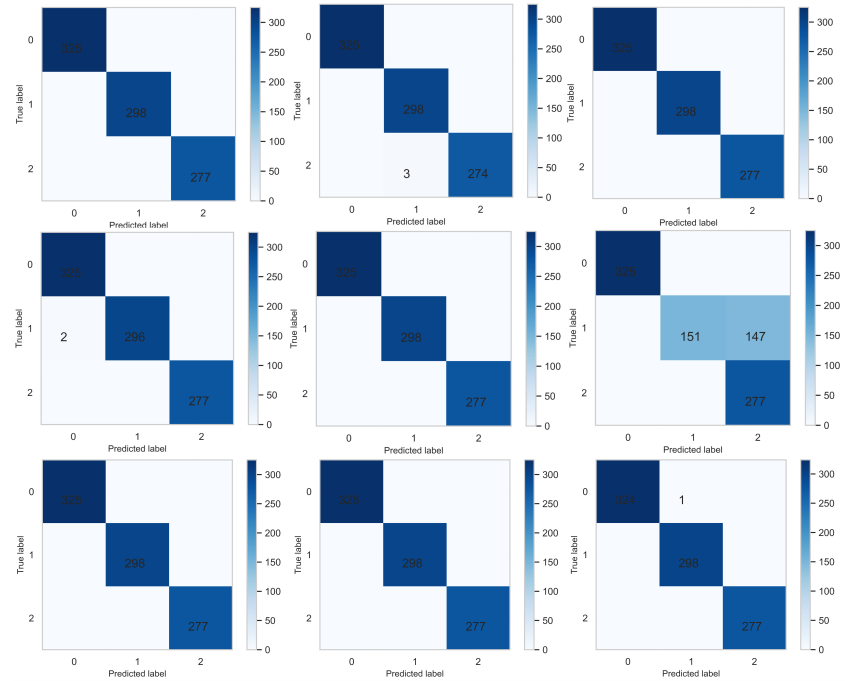
Figure 24. Confusion Matrix for the Models using the equivalent series resistance